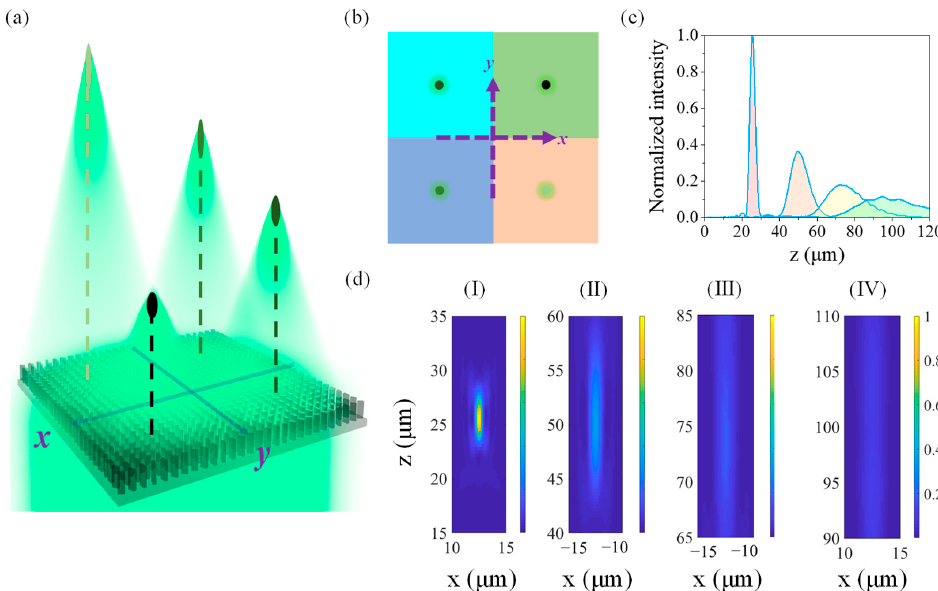
Figure 5. A metalens with different focal lengths on different planes in space. ( a ) A metalens with four focal points in space. ( b ) Regional distribution of the four sublenses and the projection of the focal points on the horizontal plane. ( c ) Light intensity distributions of each sublens of the multifocal metalens along the respective optical axes. ( d ) Intensity distributions of the focal field for a multifocal metalens in the x – z plane ( y = 12.5 μ m). (I) x ∈ [10, 15] and z ∈ [15, 35]. (II) x ∈ [ − 15, − 10] and z ∈ [40, 60]. Intensity distributions in the xz plane ( y = − 12.5 μ m). (III) x ∈ [ − 15, − 10] and z ∈ [65, 85]. (IV) x ∈ [10, 15] and z ∈ [90, 110].